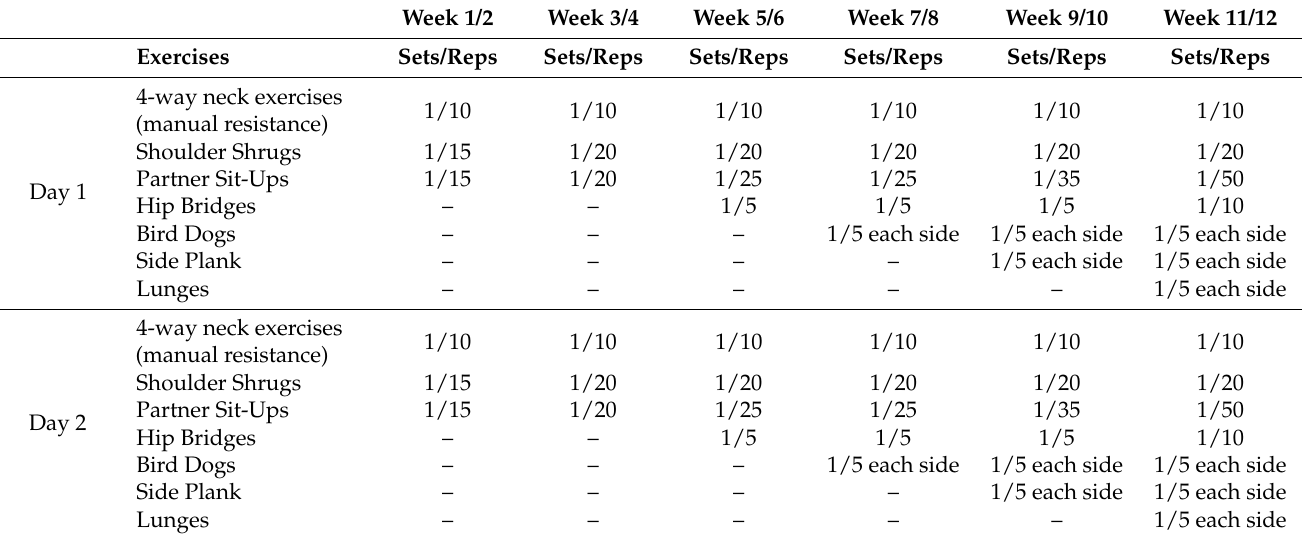
Table 1. Get aHEAD Safely in Soccer™ neck and core strengthening exercise